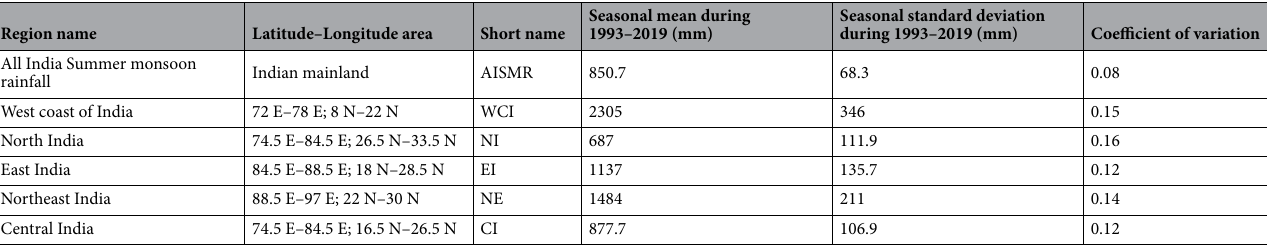
Table 1. Details of homogeneous rainfall regions considered in the